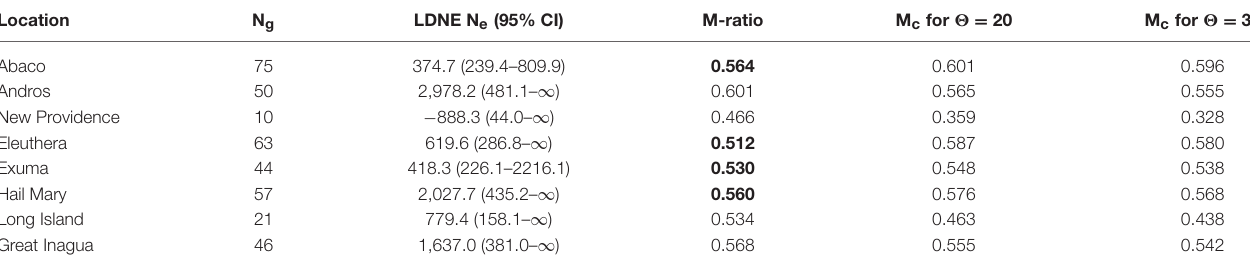
TABLE 4 | Summary of effective population size, N e per location with 95% confidence intervals, and M-ratio